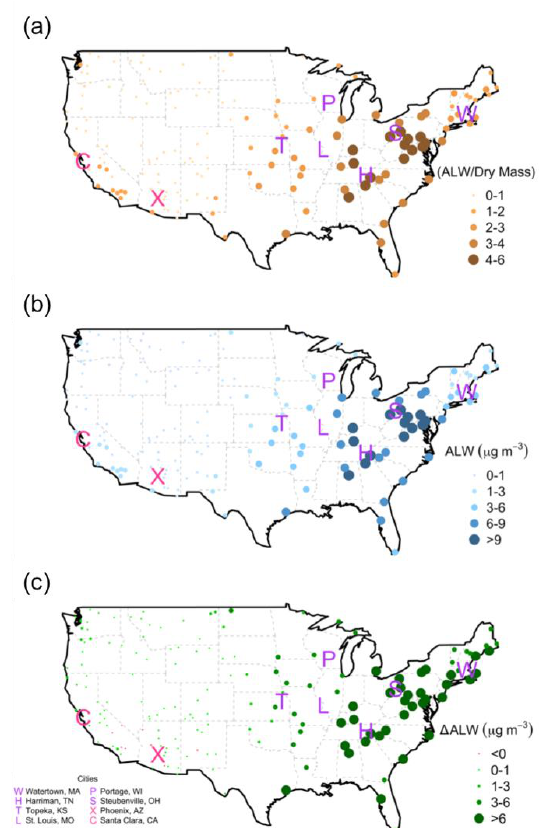
Figure 1. Yearly average in 2004 at Interagency Monitoring of PROtected Visual Environments (IMPROVE) monitoring sites of ( a ) ratio of aerosol liquid water (ALW) mass per measured PM 2.5 ‘dry’ mass ( b ) ambient ALW mass concentrations and ( c ) equivalent concentration loss upon filter equilibration to standard laboratory conditions. Point color and diameter are relative to ALW per dry mass ratio (orange), ALW mass (blue), and ALW mass difference (green, red). Green indicates ALW loss during equilibration and red indicates ALW gain.